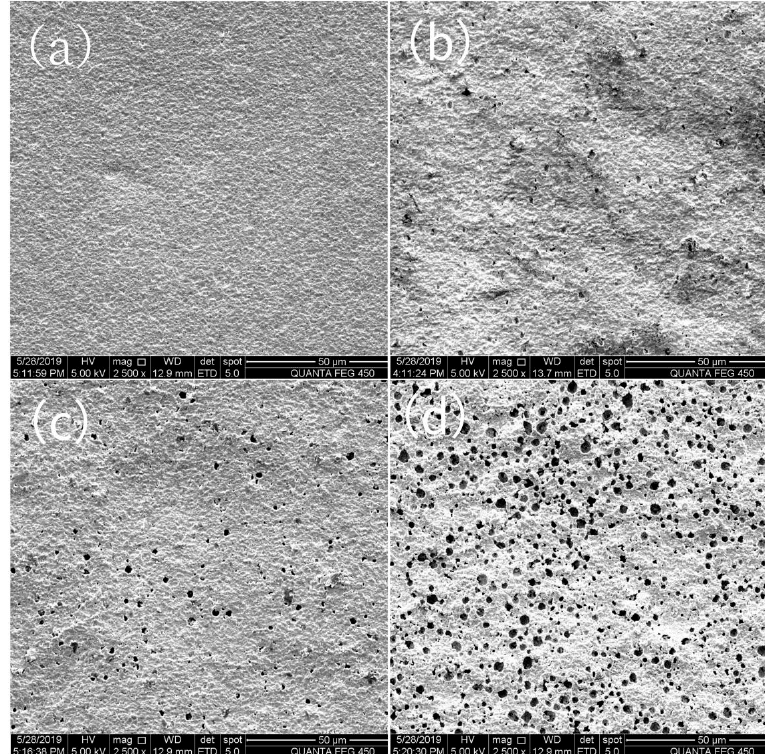
Figure 3. Field emission scanning electron microscope (FESEM) graph of the fabricated yttria-stabilized zirconia (YSZ) porous layer with different doping ( a ) 0 wt%, ( b ) 3 wt%, ( c ) 10 wt% and ( d ) 15 wt%.